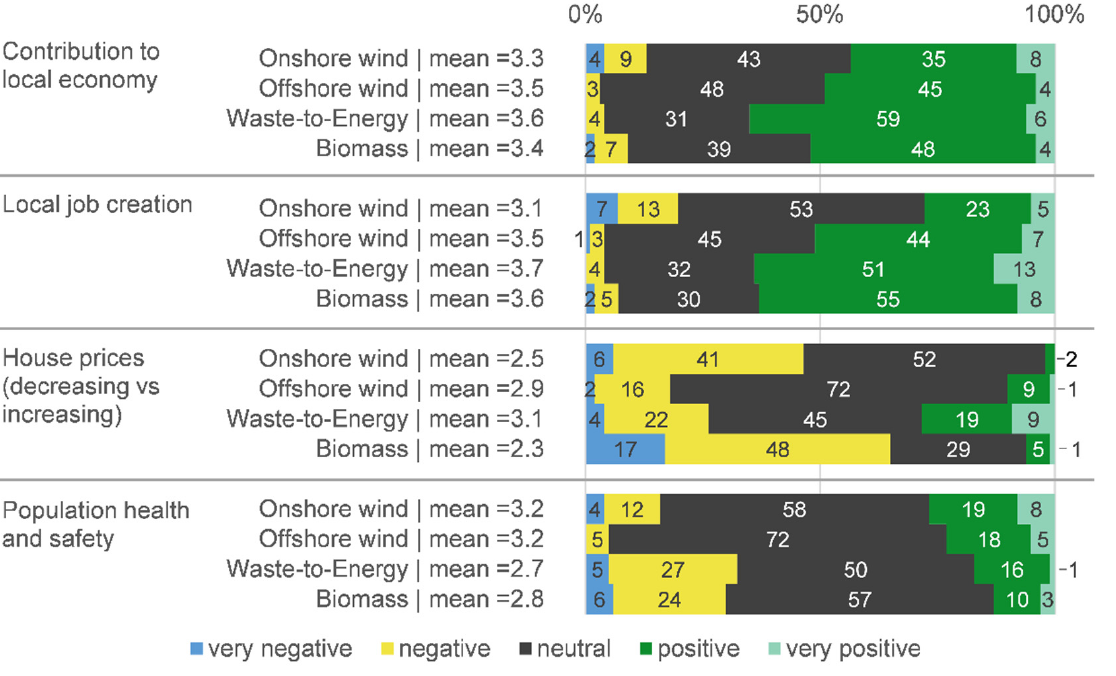
Figure 4. Experienced level of disturbance in the energy neighborhoods in % per survey group. For the calculation of the mean value, a scale from 1: very negative to 4: no impact was used. In the case of waste-to-energy and biomass plants, the impacts were experienced dif- ferently depending on the level of exposure to the power plants, which was analyzed by the comparison of the two sample groups located at different distance to the plant. For the